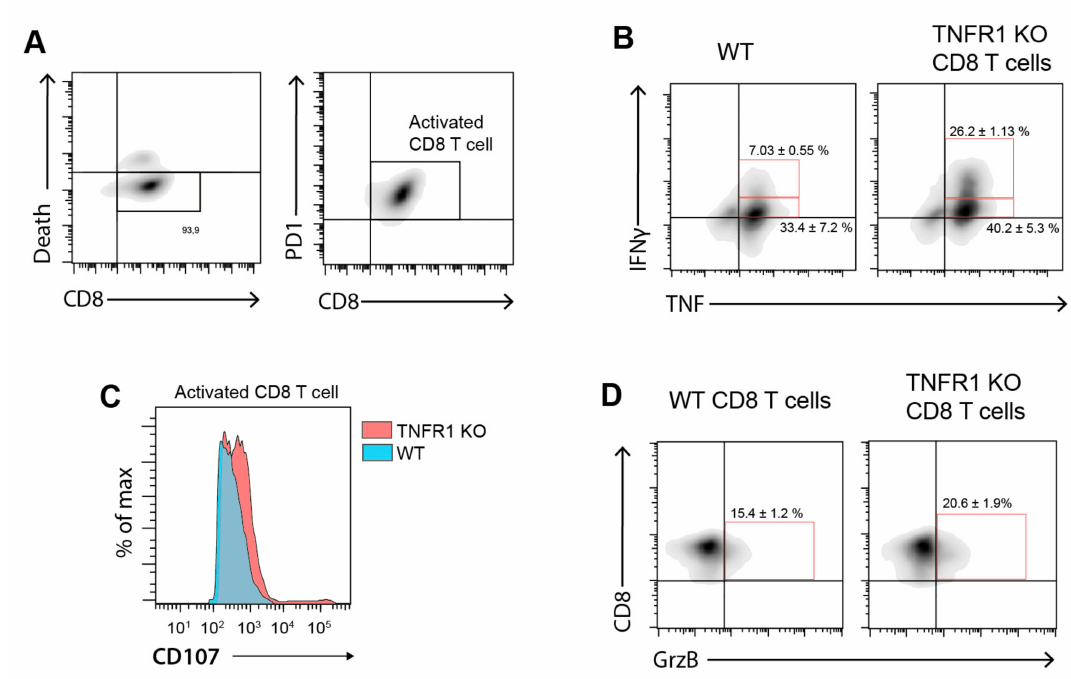
Figure 7. TNFR1 expression modulates activation state of CD8 + T cells in the presence of melanoma conditioned media. ( A ) Gating strategy of magnetic-isolated splenic CD8 + T cells (left panel) from C57BL / 6 WT or TNFR1 KO mice. The right panel shows anti-CD3 / CD28-activated CD8 + T cells during 96 h in the presence of CM from B16.F1 melanoma cells. ( B ) Intracellular IFN- γ and TNF- α in activated CD8 + T cells from WT or TNFR1 KO mice cultured in the presence of CM from B16.F1 cells. ( C ) Degranulation (CD107a + ) of WT or TNFR1 KO activated CD8 + T cells in the presence of CM from B16.F1 cells. ( D ) Granzyme-B production on WT or TNFR1 KO activated CD8 + T cells in the presence of CM from B16.F1 cells. DotPlots ( A , B , D ) and histograms ( C ) are representative plots of at least two independent